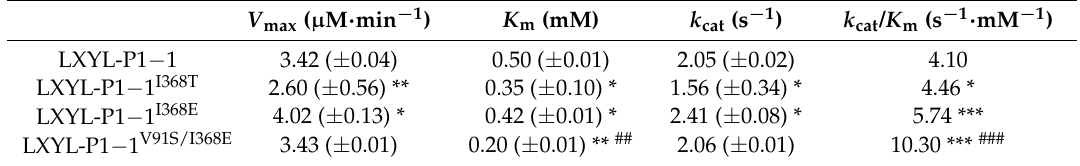
Table 1. Kinetic parameters for the mutated enzymes using XDT as the